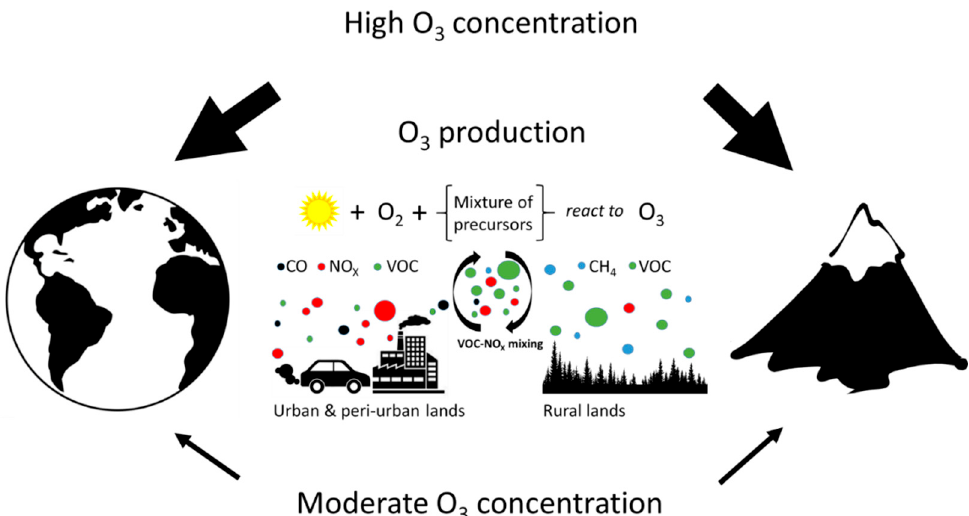
Figure 1. Scheme of tropospheric ozone (O 3 ) formation. Tropospheric ozone is formed in a complex series of photochemical reactions driven by ultraviolet (UV) solar radiation. NO 2 is photolyzed to form NO and an electronically excited oxygen atom, O, which reacts with molecular oxygen in the atmosphere (O 2 ) to form O 3 . However, O 3 may also regenerate NO 2 in the presence of NO, thus keeping a photo-stationary state. Therefore, net O 3 production occurs when O 3 precursors, such as carbon monoxide (CO), methane (CH 4 ) and volatile organic compounds (VOCs), are present in the atmosphere at appropriate concentrations. This chain of photochemical reactions is catalysed by hydroxide anion (OH − ), hydroperoxyl radical (HO 2 ), NO and NO 2 . Enhanced O 3 production thus occurs under high levels of UV radiation and when the concentration of precursors reaches critical levels. Transport of precursors and catalysts from urban and industrial lands (CO, NO x and VOC) to rural conditions enhances mixing of polluted air plumes with clean rural air (enriched with CH 4 and VOC) and results in a VOC/NO x ratio conducive for O 3 formation. Therefore, latitudinal and elevational distribution differences in O 3 concentration are likely caused by the distribution of O 3 precursor sources associated with industrialization development and/or by an elevational increase in UV radiation.